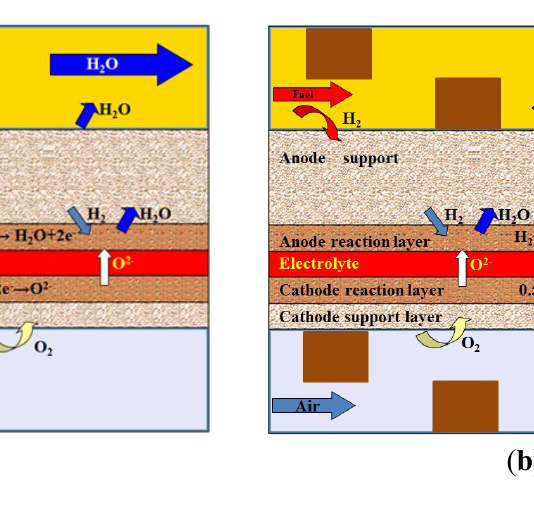
Figure 2. The schematic of the SOFC model with: ( a ) conventional straight interconnector; and ( b ) bi-layer